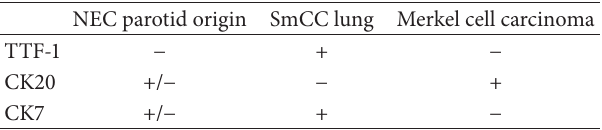
Table 1: Immunohistochemical features that help in the differential diagnosis between NEC from the parotid, SmCC of the lung, and Merkel cell